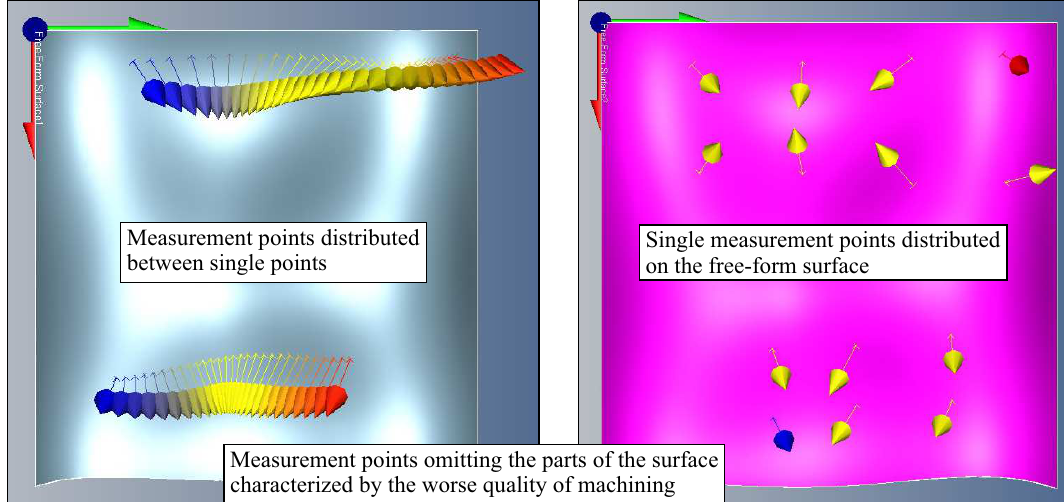
Figure 16. The selected methods of the distribution of measurement points available in the Calypso